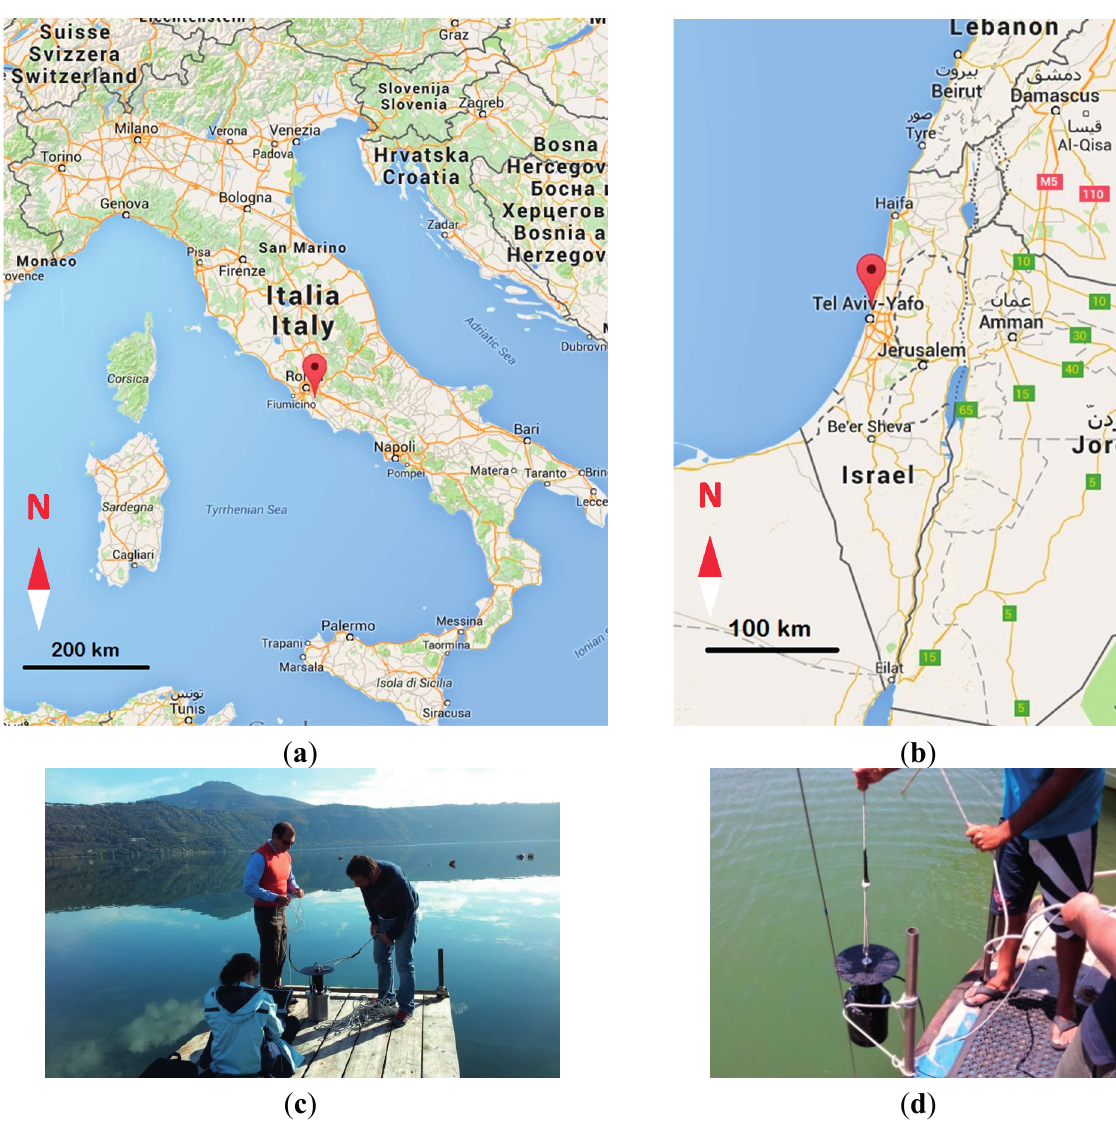
Figure 10. Location of the two sites where the sensor was tested and some pictures taken during the campaigns: ( a , c ) Albano Lake (Italy); ( b , d ) Herzliya Harbor